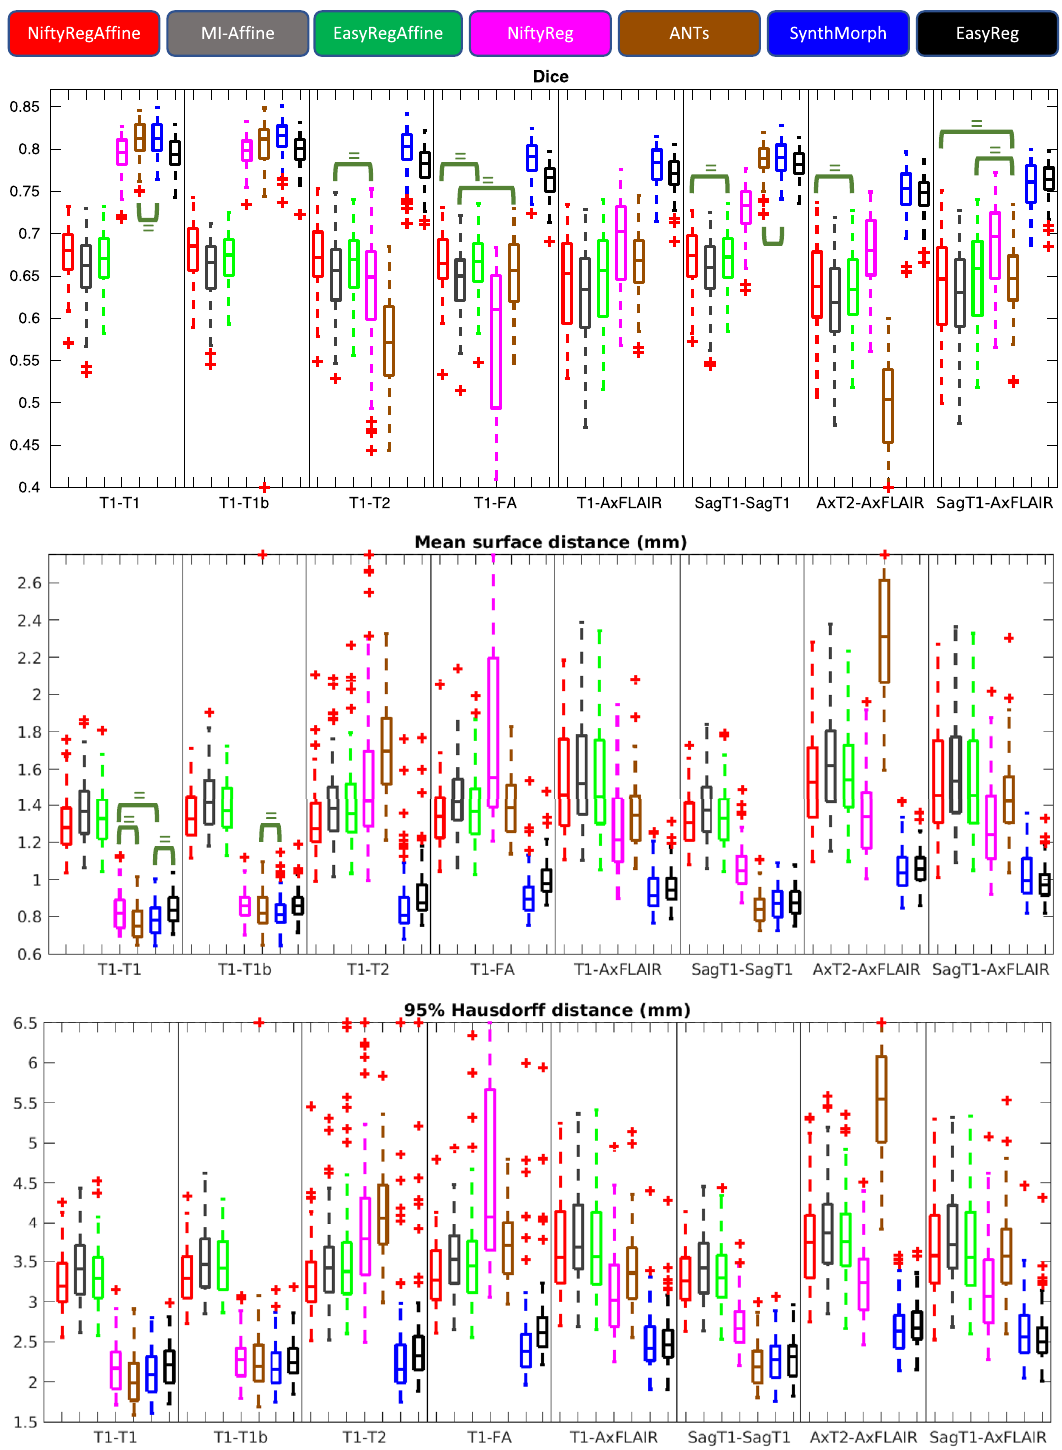
Figure 3. Box plot for the registration accuracy metrics achieved by the different methods in the different registrations tasks: Dice scores (top), mean surface-to-surface distances (center), and 95% Hausdorff distance (bottom). On each box, the central mark is the median, the edges of the box are the 25th and 75th percentiles, and the whiskers extend to the most extreme datapoints that are not outliers (which are plotted as crosses). The green brackets indicate lack of statistically significant differences between two methods ( p > 0.05 ), according to a non-parametric Wilcoxon test; note that we mark the lack (rather than existence) of differences not to clutter the figures, since most differences are significant (due to the large sample size and to the fact that the values have little noise, as they are averages over brain